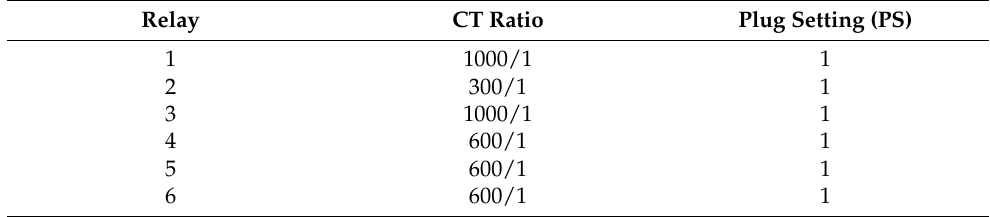
Table 10. Plug settings (PS) and CT ratios of the relays (Case